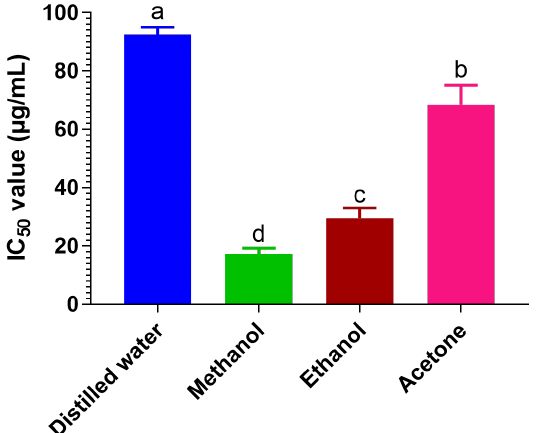
Figure 3. The 50% inhibitory concentration (IC 50 ) values of DPPH scavenging activity of different Caralluma edulis extracts. All values are the mean ± SD ( n = 3). Means of a column with different letters significantly differ by Tukey’s test at p < 0.05.